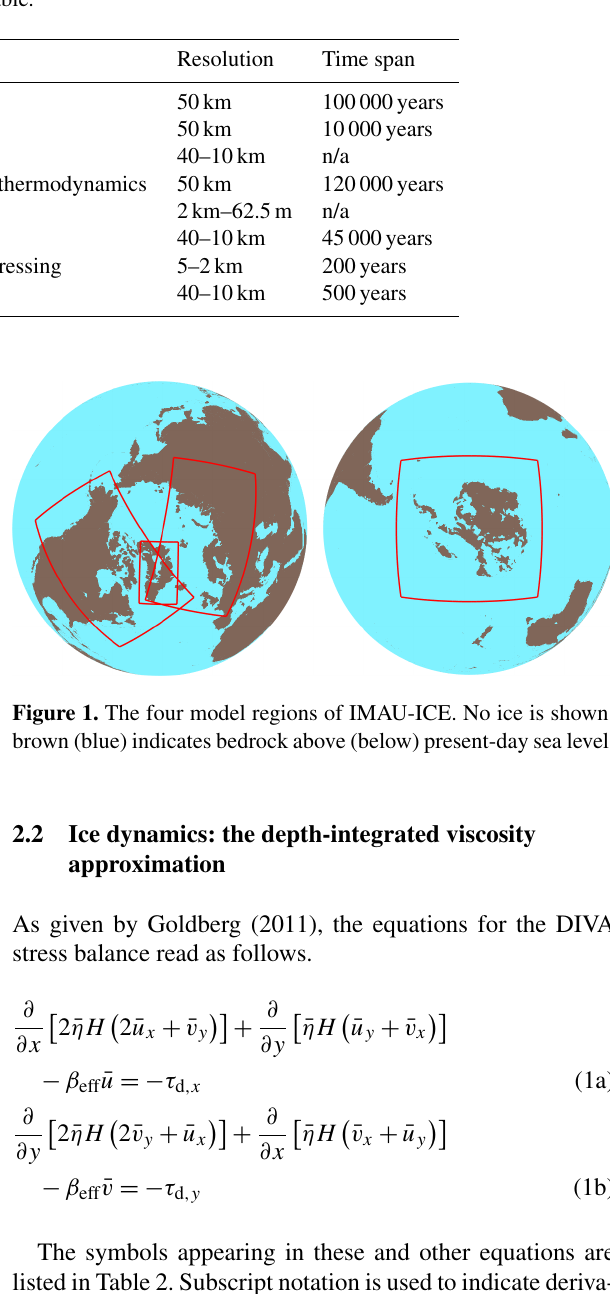
Table 1. Benchmark experiments performed with IMAU-ICE. Each experiment aims to verify a different model component at a different (range of) resolution(s) and over a different time span. n/a – not applicable.